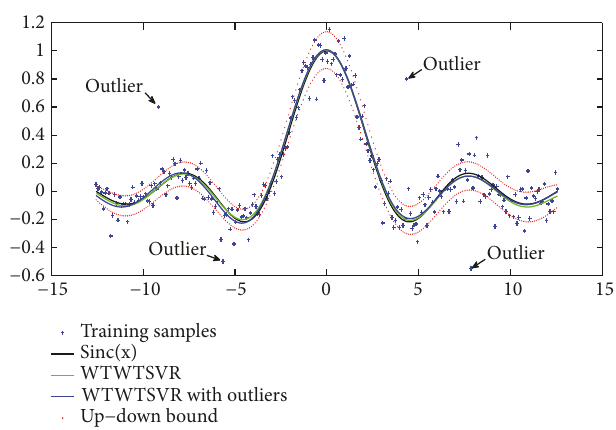
Figure 4: Performance of WTWTSVR on Sinc function with and without outliers.